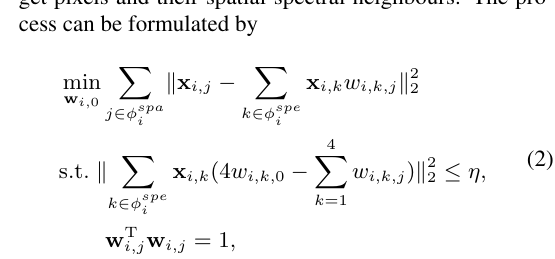
Table 1. Class names as well as the number of training and test samples for each class on the hyperspectral dataset over the area of Indine Pines.